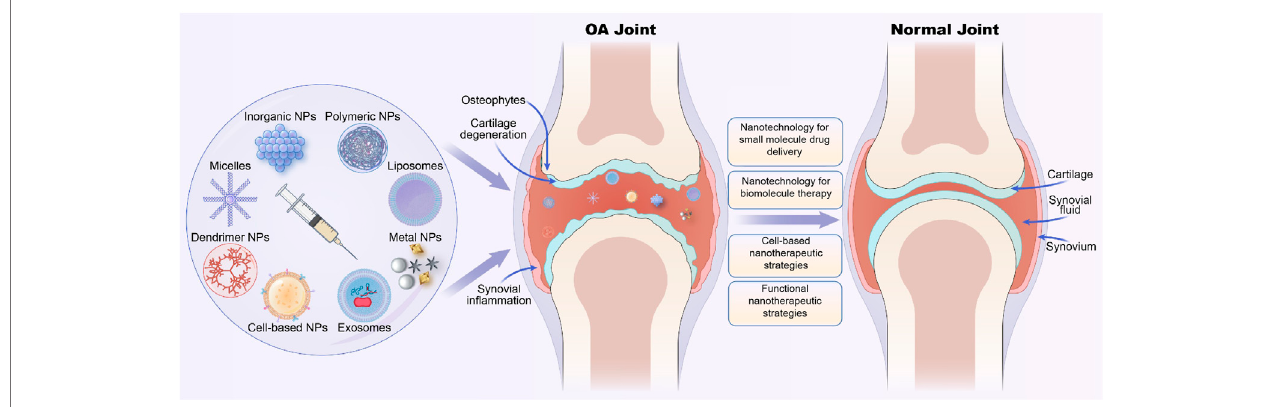
FIGURE 1 | Various nano-therapeutic strategies based on different nanoparticles for osteoarthritis (OA) treatment.